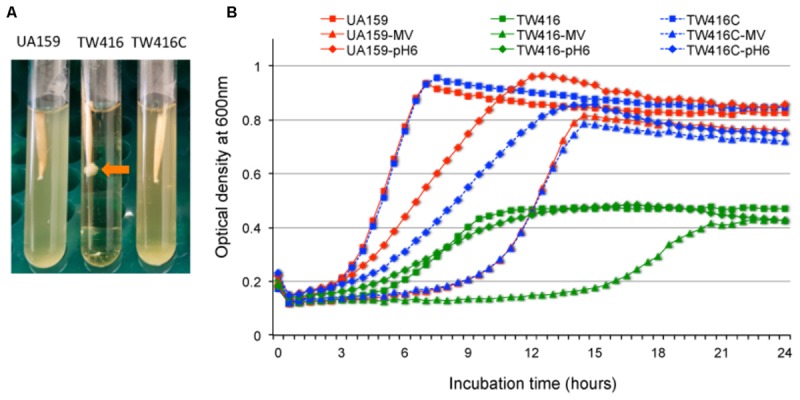
Growth characterization of the mecA mutant. (A) Growth phenotypes of S. mutans wild-type (UA159), the mecA mutant (TW416) and its complement strain (TW416C) when grown in BHI broth overnight. Arrow indicates severe clumping of the mecA mutant at the tip of the tooth pick. (B)
S. mutans strains grown in BHI broth, BHI broth with pH adjusted to 6.0 and BHI broth with inclusion of methyl viologen at 12.5 mM. The optical densities of the cultures at 600 nm were recorded continuously using a Bioscreen C. Data presented in panel (B) are representatives of three separate experiments.